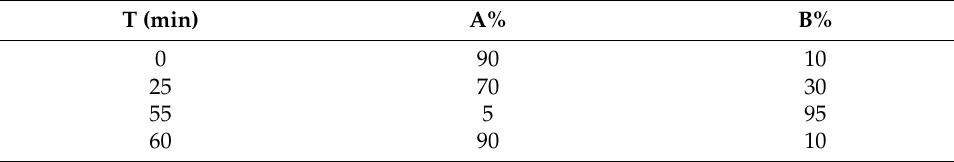
Table 1. The elution gradient for the HPLC